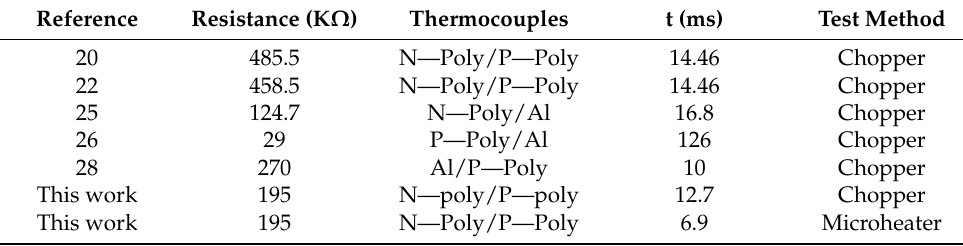
Table 3. Thermopile sensor response time, measured by different test